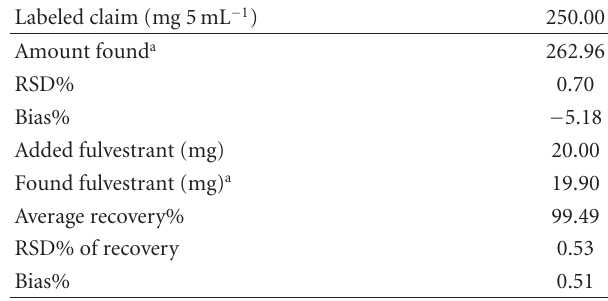
Table 2: Results obtained from the determination and recovery experiments in injectable dosage